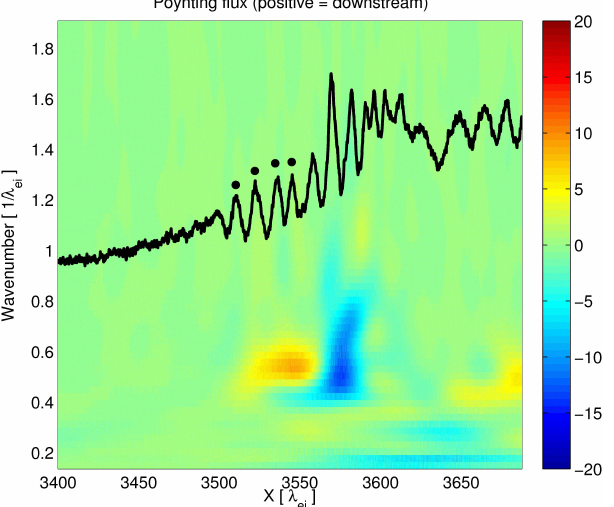
Fig. 7. Color coded Poynting flux S as a function of wavenumber and x shock in the shock ramp at t(cid:127) ci = 9 . 2. The trace of the mag- netic field B z component is shown for reference. The wave train indicated by filled dots is followed in time.